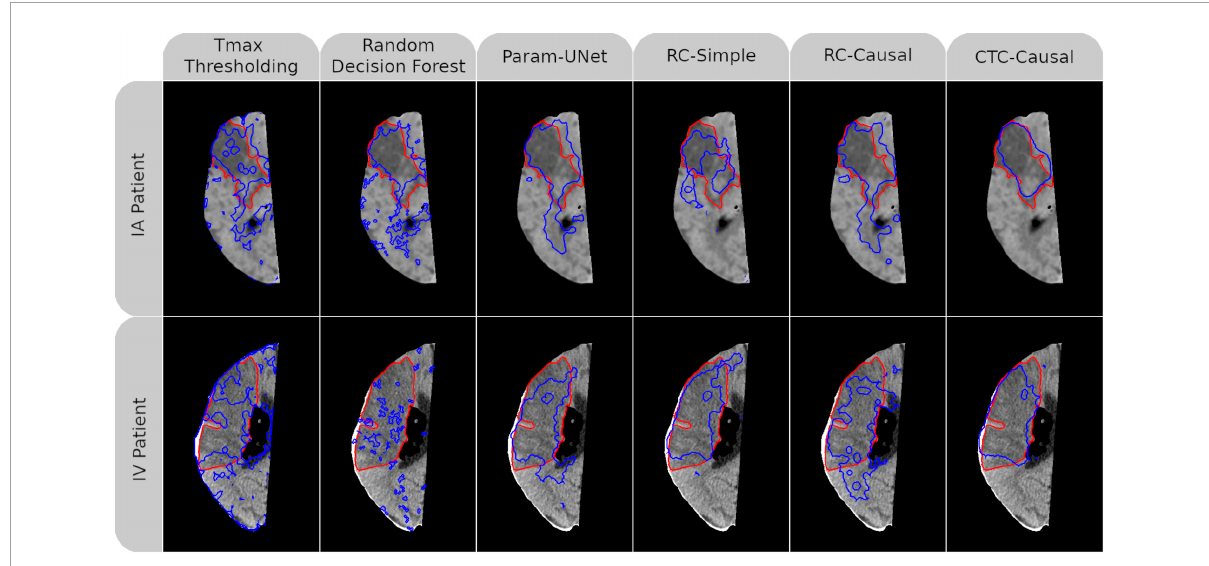
FIGURE2 Follow-up non-contrast CT imaging with superimposed ground-truth lesion segmentation (red) and tissue outcome prediction (blue). An AIS patient treated with intraarterial mechanical thrombectomy (IA) is shown in the top row while another treated with intravenous tPA (IV) is shown in the bottom row. A different tissue outcome prediction method is shown in each column. For both patients, the individual slice with the greatest cross-sectional ground truth area is shown. Dice values for each (3D) tissue outcome prediction are, clockwise from the top-left, 0.45, 0.40, 0.54, 0.20, 0.48, 0.75, 0.73, 0.56, 0.70, 0.60, 0.24, and 0.53. Abbreviated model names correspond to: Tmax thresholding, random decision forests (RDF), deep learning from perfusion parameter maps (Param-UNet), deep learning from deconvolved residual curves with